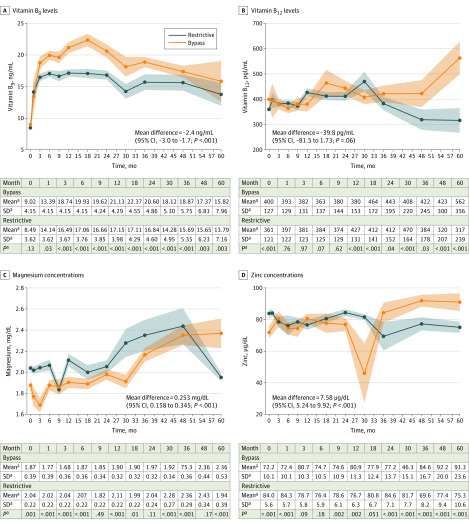
Five-year Trajectories in Serum Vitamin and Mineral ConcentrationsSI conversion factors: To convert vitamin B9 to nanomoles per liter, multiply by 2.266; B12 to picomoles per liter, multiply by 0.7378; and magnesium to millimoles per liter, multiply by 0.4114.aEstimated margins and 95% CIs are plotted immediately after fitting inverse probability of treatment weighted linear mixed models conditioned on the treatment propensity score and additionally adjusted for sex. Restrictive includes patients who underwent laparoscopic sleeve gastrectomy; bypass includes patients who underwent laparoscopic Roux-en-Y gastric bypass or one-anastomosis gastric bypass.